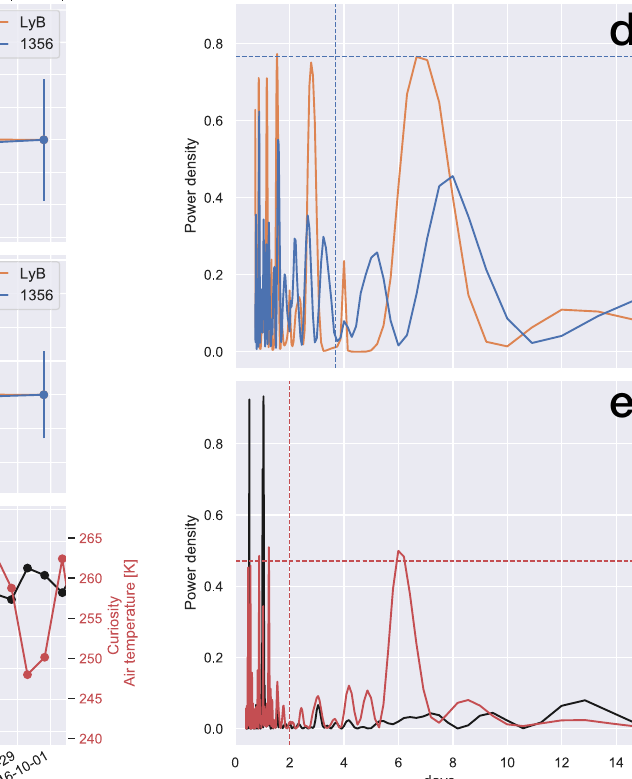
power spectrum of d airglow emissions and e air temperature and pressure cal- culated using the Lomb-Scargle periodogram method. Vertical and horizontal dashed lines correspond to Nyquist frequency periods and con fi dence levels of 90% and 99%,